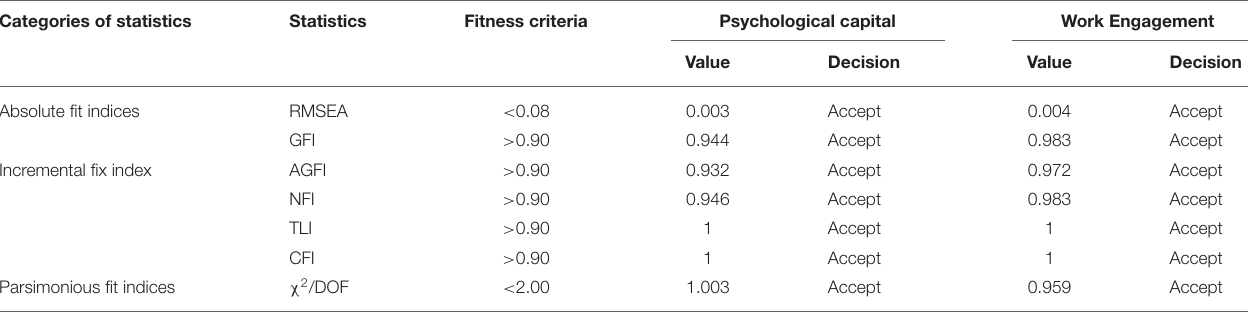
TABLE 4 | Fit indexes for the measurement models.